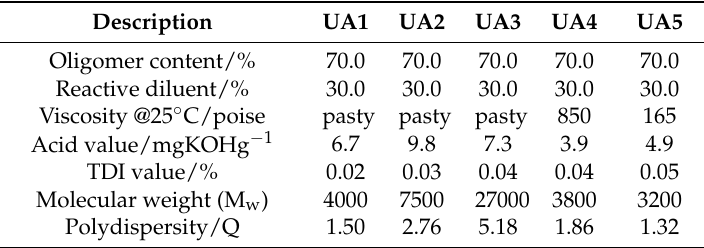
Table 6. Properties of the PFAD-based urethane acrylate